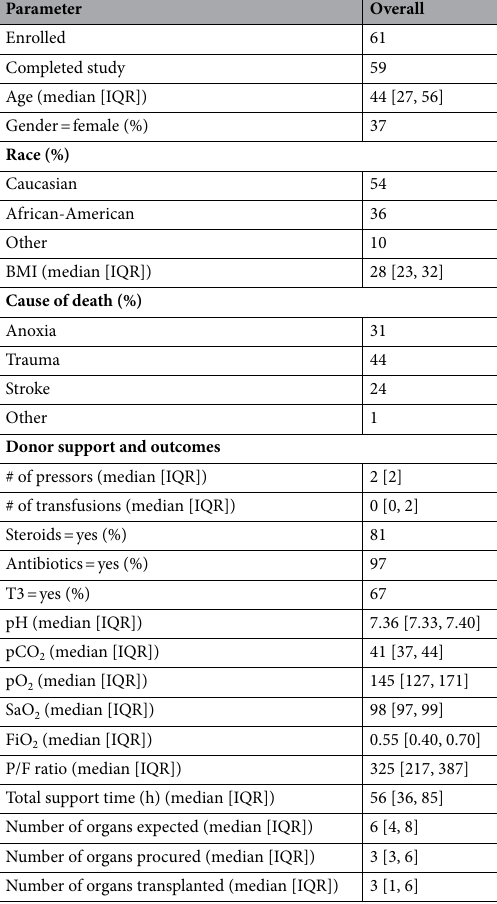
Table 1. Donor demographics, clinical status, procurement